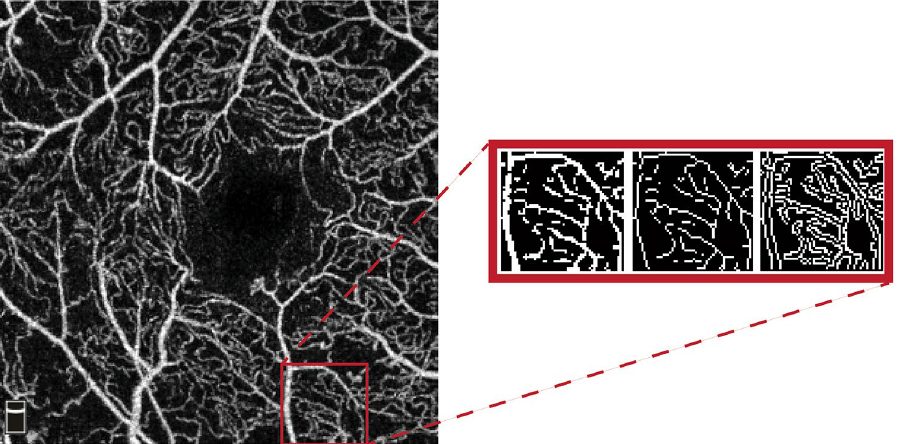
Figure 1. Optical coherence tomography angiography (OCTA) image of a patient with diabetic retinopathy (left image). The enlarged inset shows the enhanced binarized image, skeletonized image, and vessel perimeter map of a region of interest, from left to right, respectively. In the skeletonized image the vessels are thinned to a single pixel making the measurement of vessels’ length a simpler task in image processing. Vessel perimeter map outlines the perimeter of each vessel which is used for measuring the vascular complexity index. It should be noted that the region of interest shown in this image, was selected for better visualization of the image processing techniques. Whole image was used for all analyses.